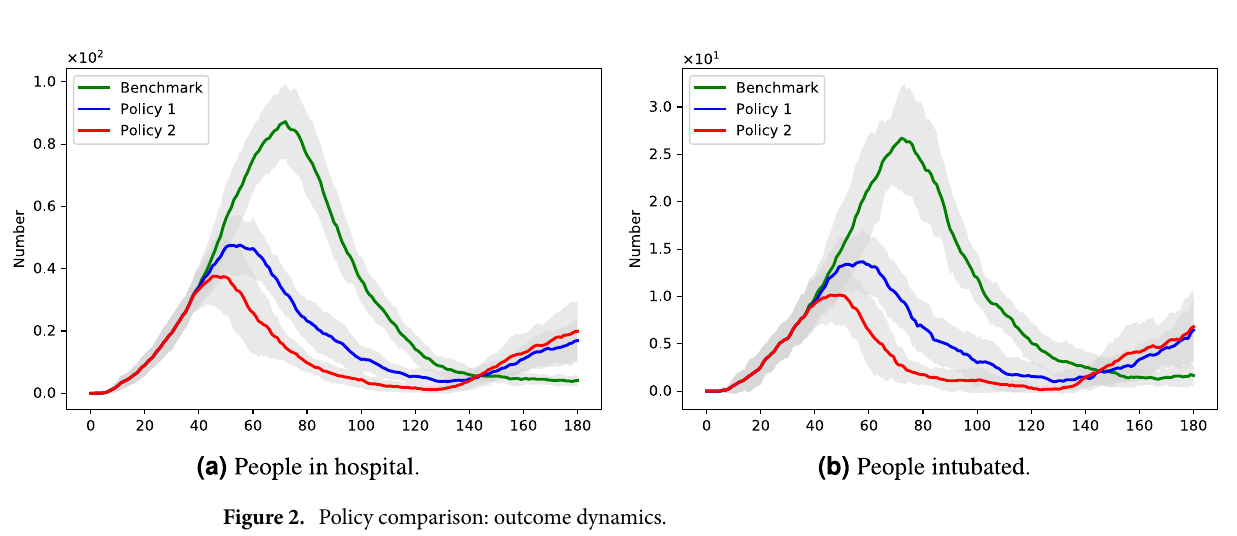
Figure 2. Policy comparison: outcome